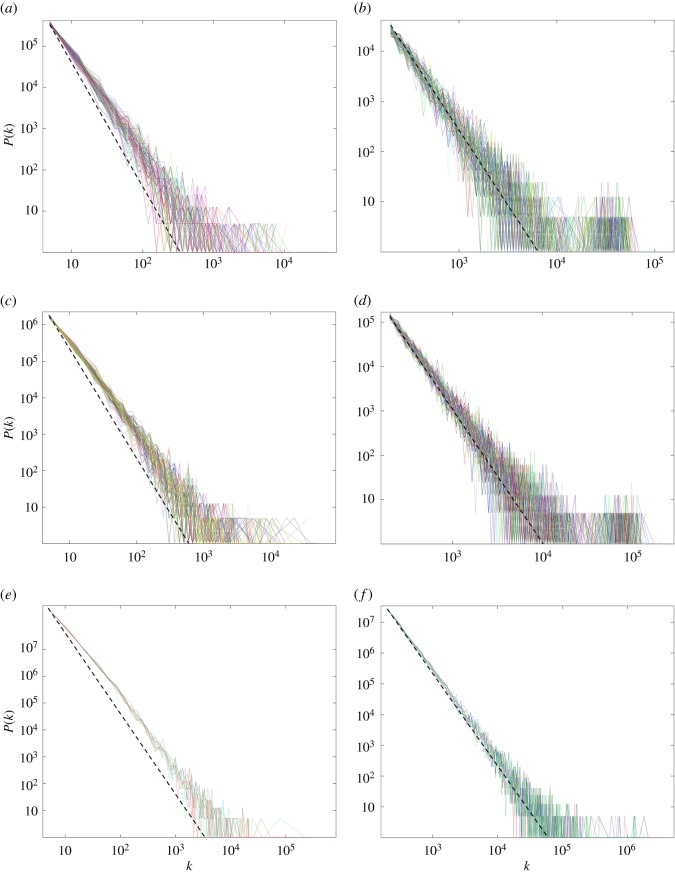
Log–log degree distributions for scale-free networks with prescribed 〈k〉. P(k) ∝ k−3 shown as dashed lines. Deviations from the k−3 scaling are observed for 〈k〉 = 4 for small k. (a) N = 512, 〈k〉 = 4 (100 networks), (b) N = 512, 〈k〉 = 20 (100 networks), (c) N = 1024, 〈k〉 = 4 (100 networks), (d) N = 1024, 〈k〉 = 20 (100 networks), (e) N = 10 000, 〈k〉 = 4 (10 networks) and (f) N = 10 000, 〈k〉 = 20 (10 networks).